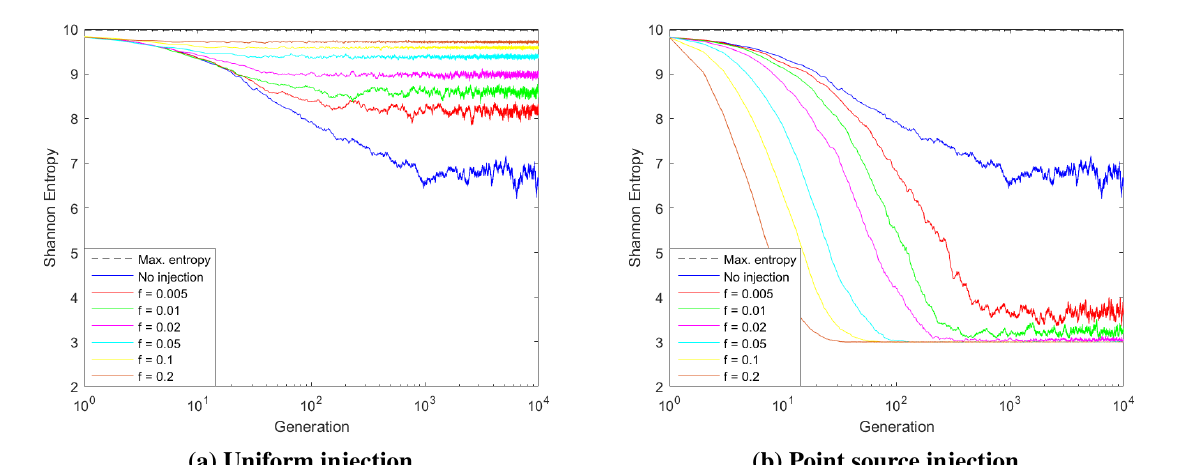
Figure 1: Shannon entropy of the box problem when replacing various fractions of the population each generation according to two different spatial